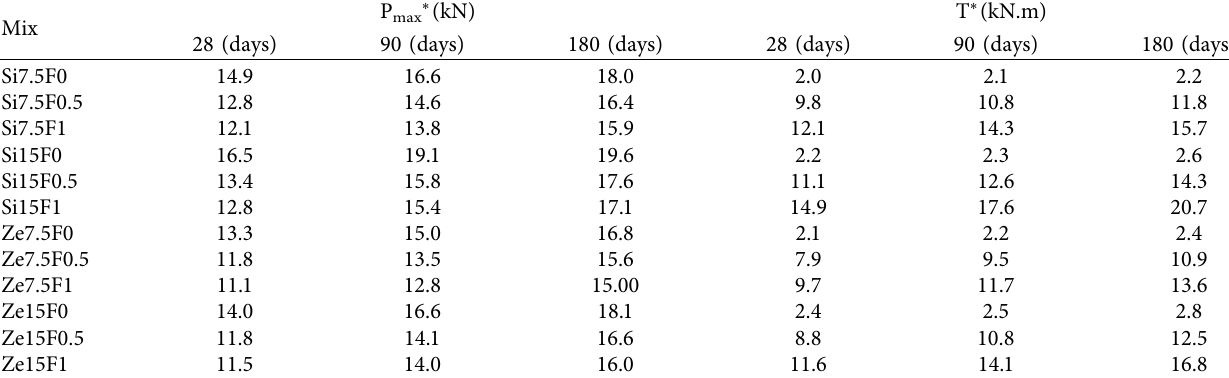
Table 8: Maximum load capacity ( P max ) and flexural toughness ( T ) results.